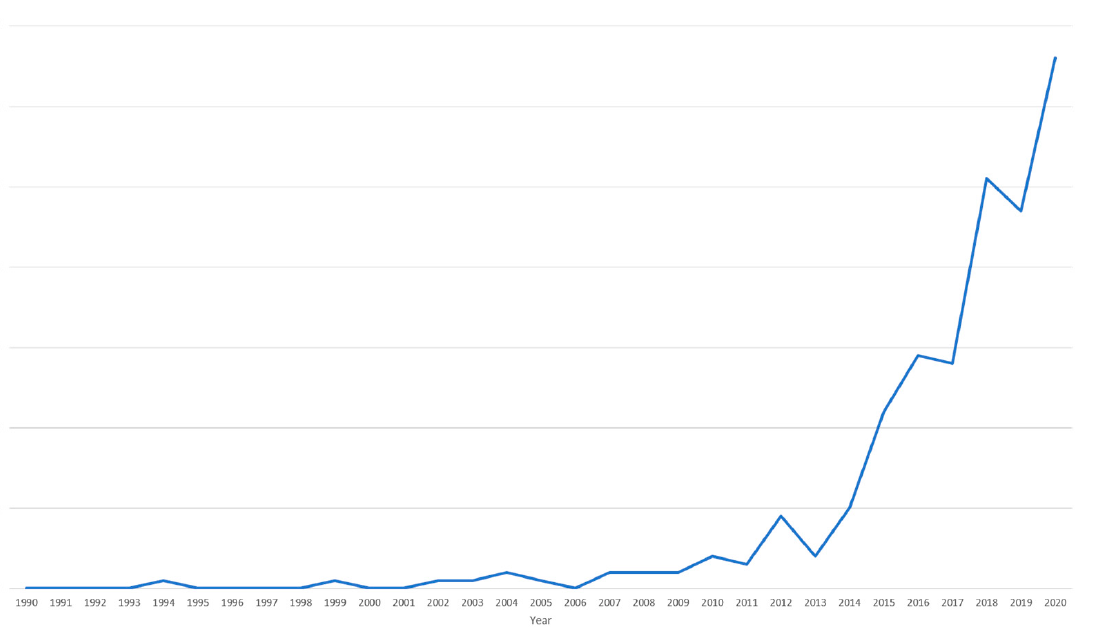
Figure 6. Documents per year for biostimulant (Appendix B—v).